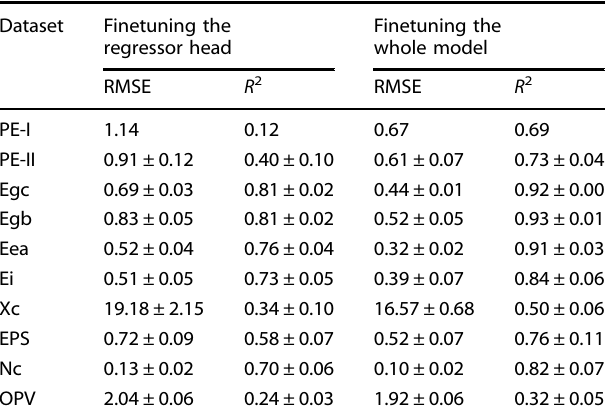
Table 7. Comparison of performance of TransPolymer pretrained between fi netuning the regressor head only and fi netuning the whole model in terms of test RMSE and R 2 .